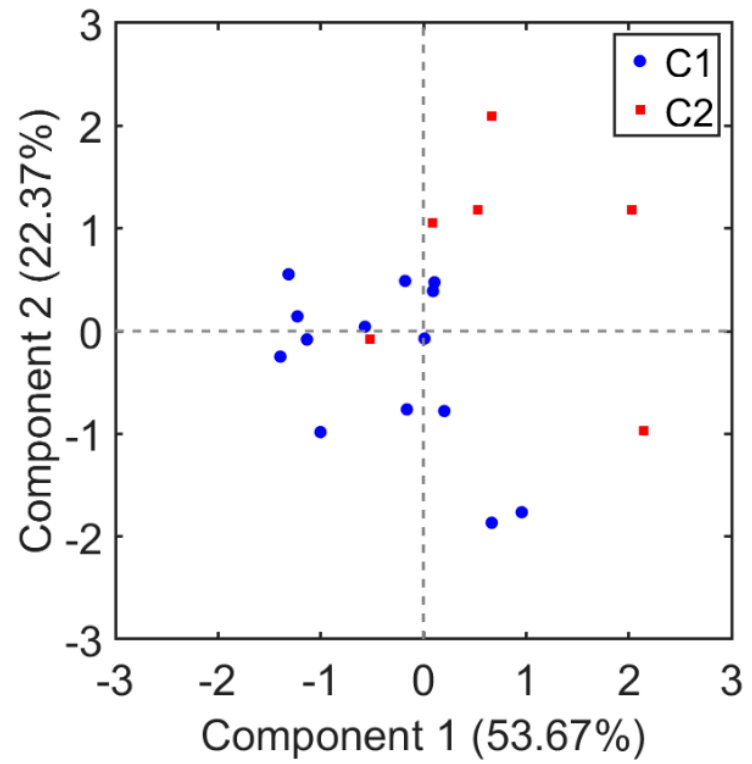
Figure 8. Distribution of the two program clusters in the component map.